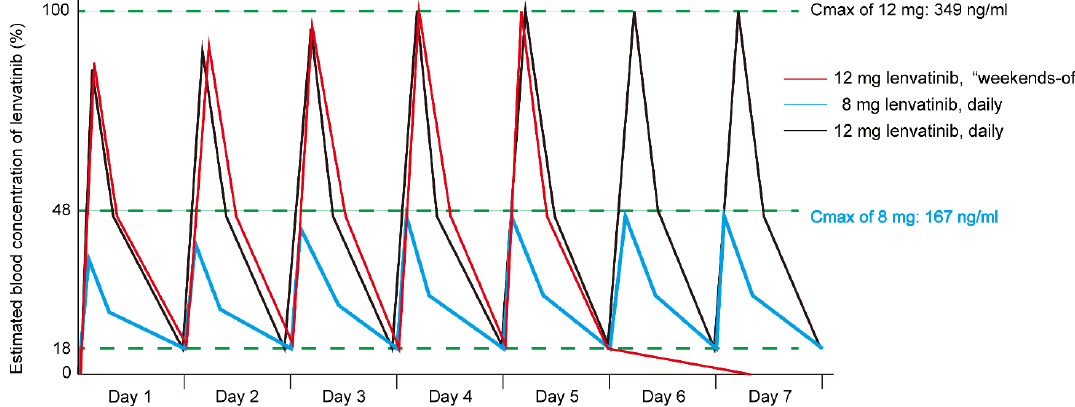
Figure 3. Simulation of the blood concentration of lenvatinib. The blood concentration curve for each administration method (red: 12 mg “weekends-o ff ” method, blue: 12 mg daily, black: 8 mg daily) was simulated according to the pharmacokinetics study of lenvatinib. The Cmax of 12 mg and 8 mg daily lenvatinib is 349 ng / mL and 167 ng / mL, respectively. The blood concentration of lenvatinib after 48 hours upon the last dose is predicted to be 1.5% of Cmax. The area under the blood concentration-time curve (AUC) of the weekends-o ff method is predicted to be 70% of that achieved with daily lenvatinib